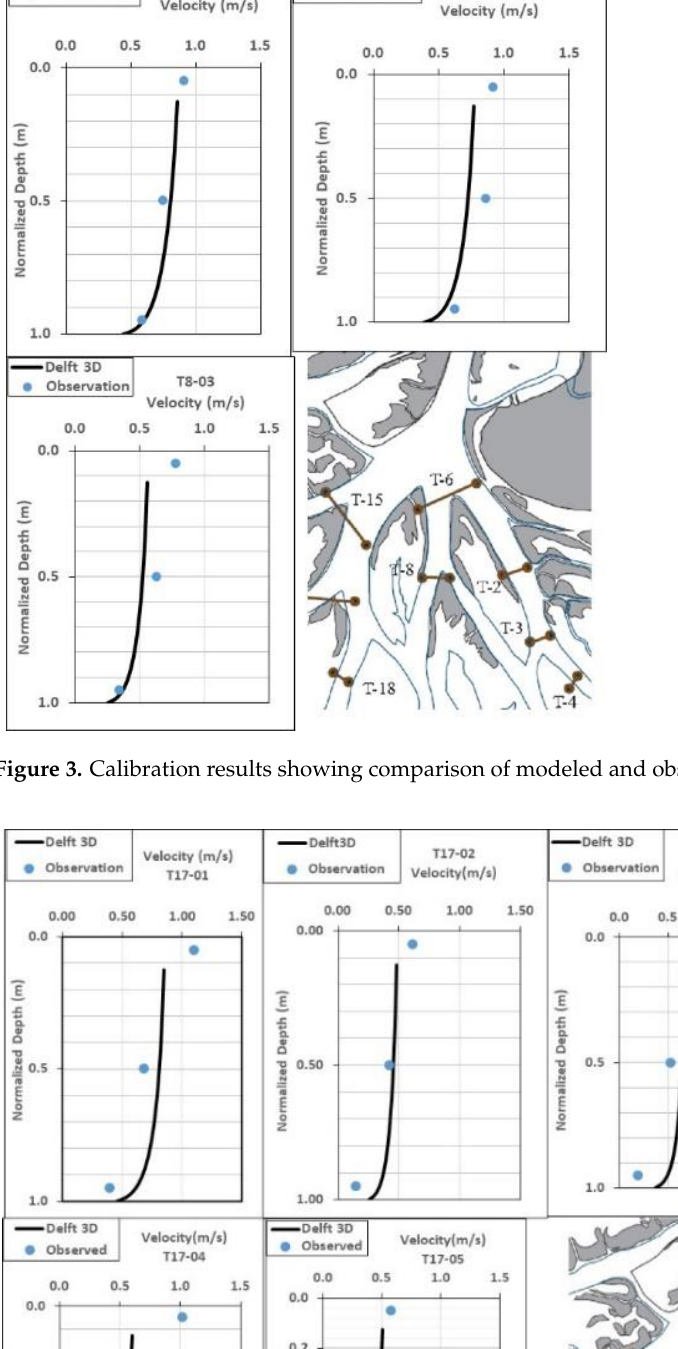
Figure 5. Validation results showing comparison of modeled and observed streamwise velocities at East Pass.